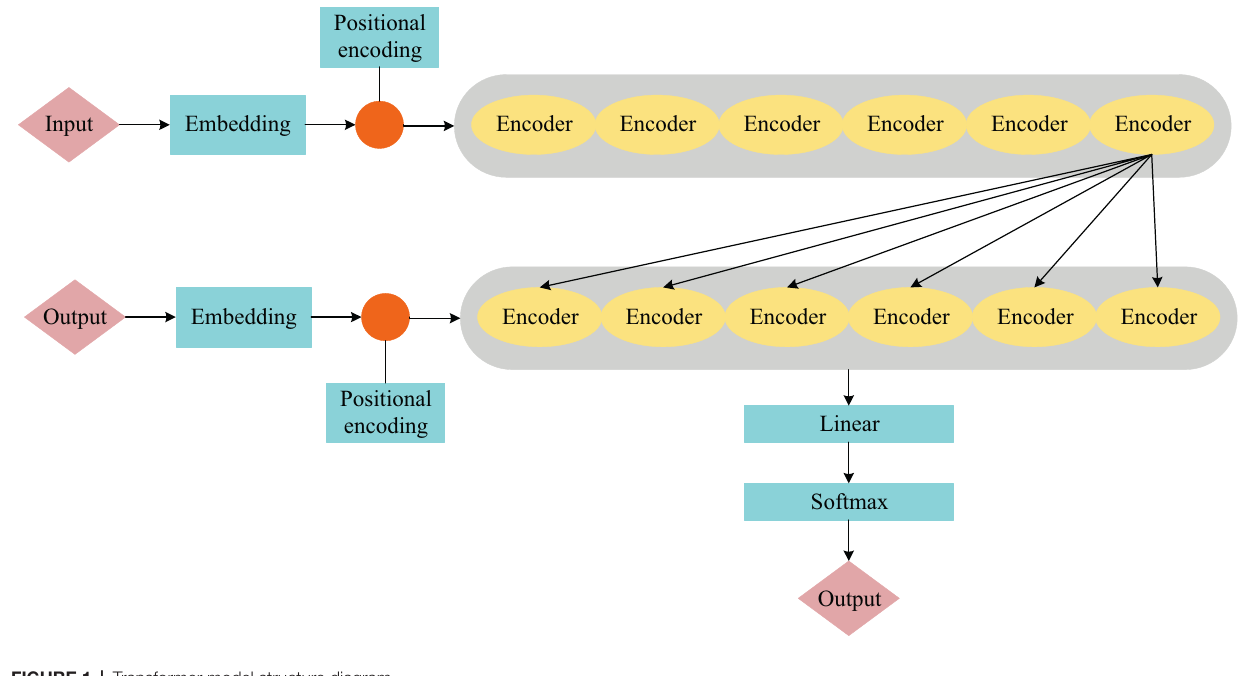
FIGURE 1 | Transformer model structure